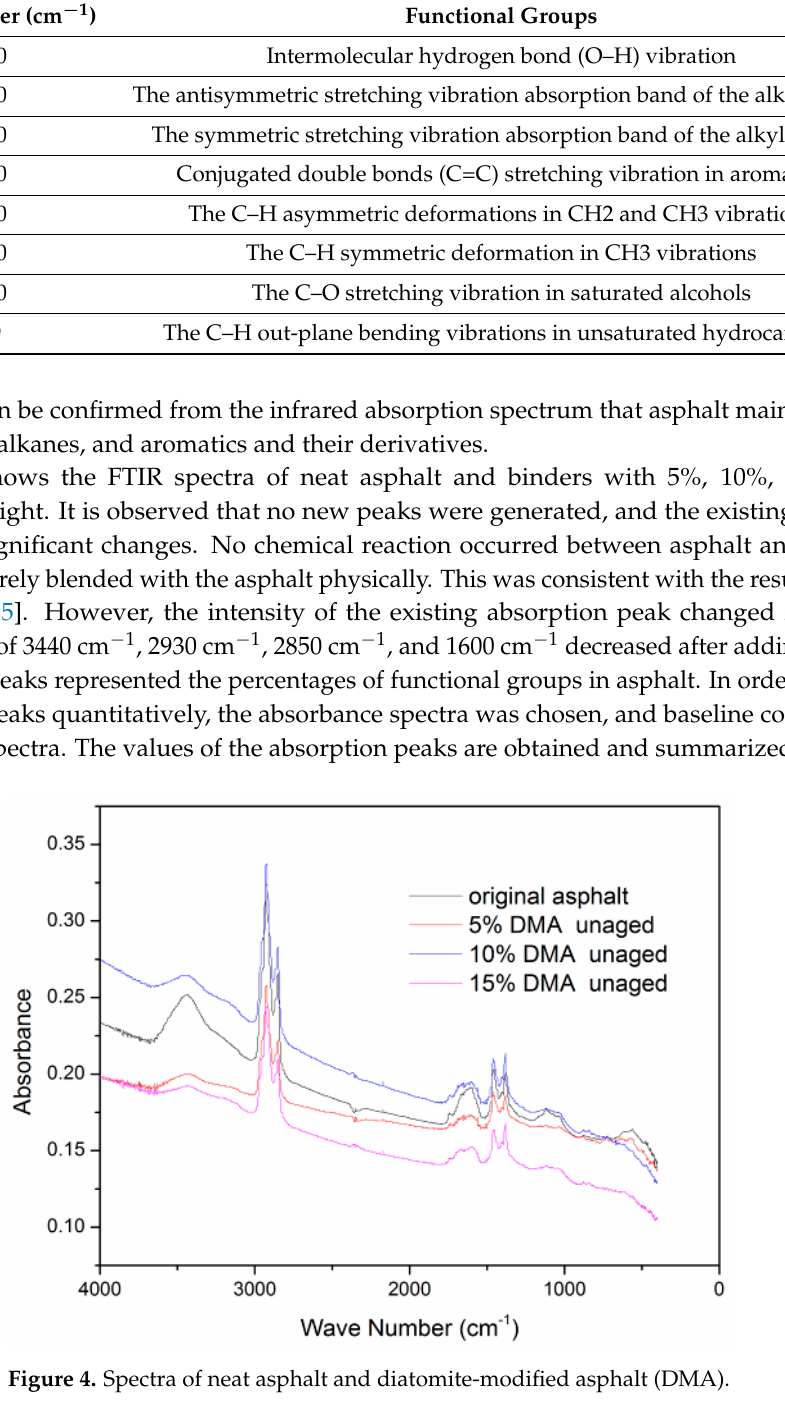
Table 4. Featured functional groups of neat asphalt.